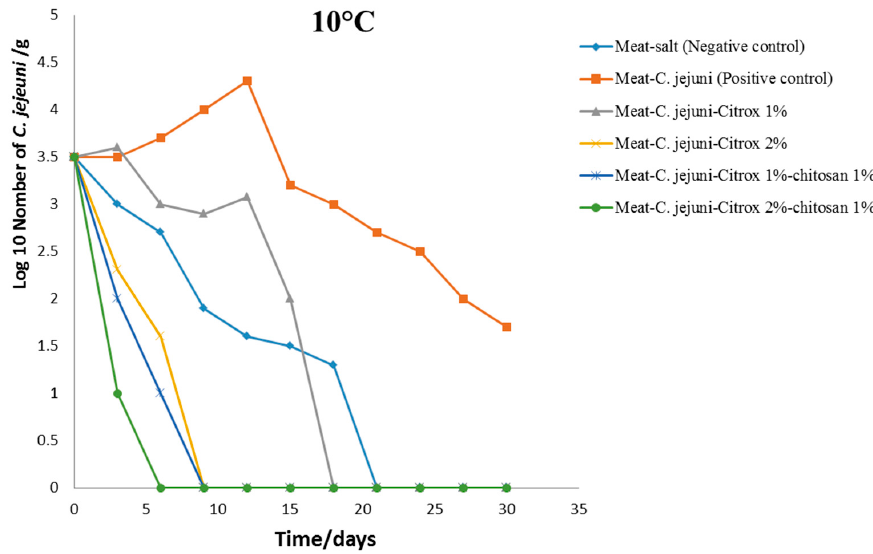
Figure 3. Total viable counts (TVCs) of Campylobacter jejuni in camel meat samples stored at 10 ◦ C.